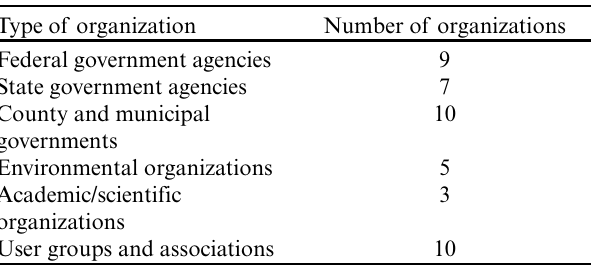
Table 1. Types and numbers of organizations participating in the Front Range Roundtable,